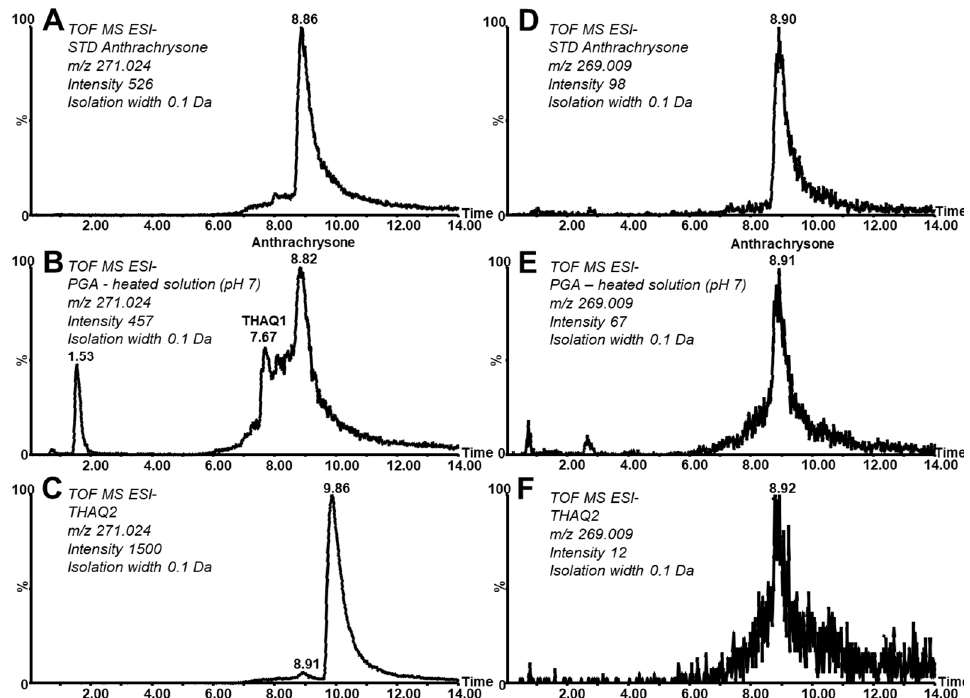
Figure 2. LC/MS analysis of anthrachrysone and its isomers. The reconstructed chromatograms at m / z 271.024: ( A ) standard of anthrachrysone (ATCS), ( B ) ATCS and its isomers formed in a heated solution of phloroglucinaldehyde (PGA), ( C ) tetrahydroxylated anthraquinone isomer 2 (THAQ2); and at m / z 269.009: ( D ) the oxidation form of ATCS in its standard solution, ( E ) the oxidation form of ATCS found in the heated solution of PGA, ( F ) THAQ2.